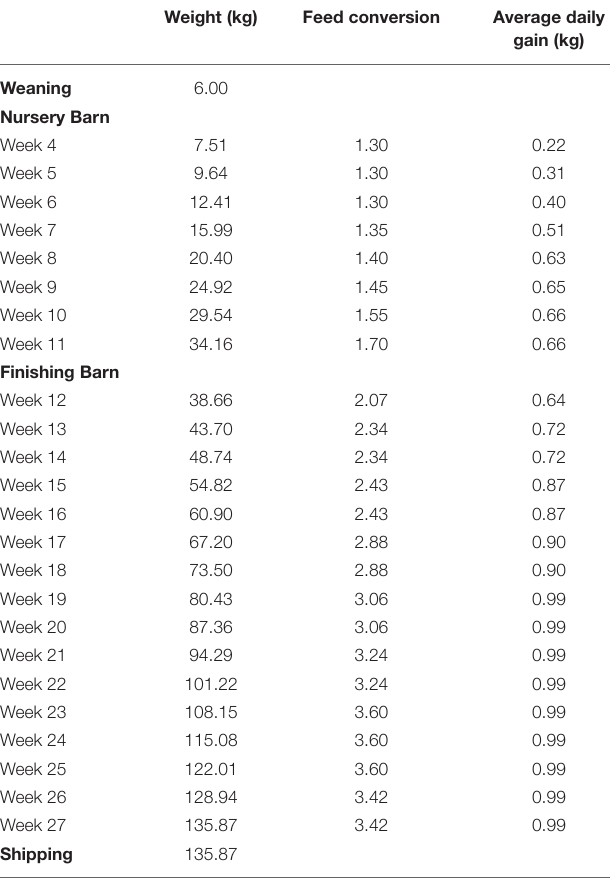
TABLE 2 | Feed and weight assumptions for growing pigs. Weight